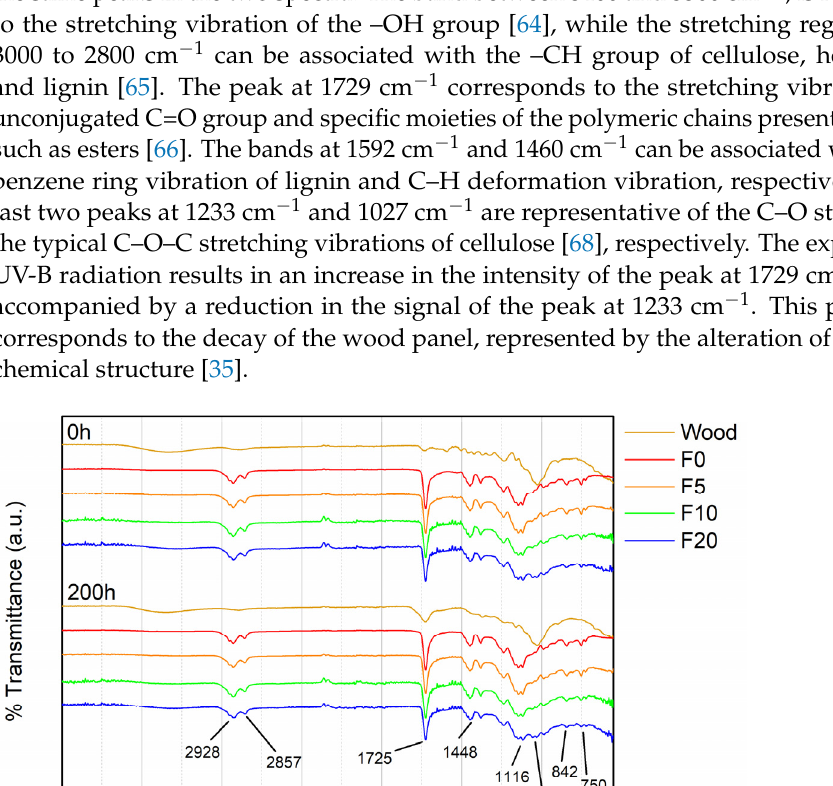
7 of 21 Figure 2. SEM micrograph of ( a ) sample F0, ( b ) sample F5, ( c ) sample F10 and ( d ) sample F20. Top